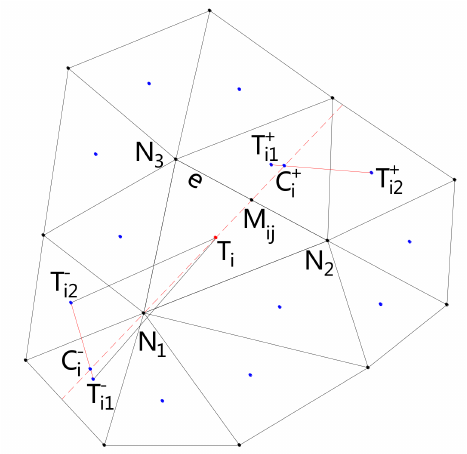
Figure 4. Sketch of Touze’s scheme on triangular